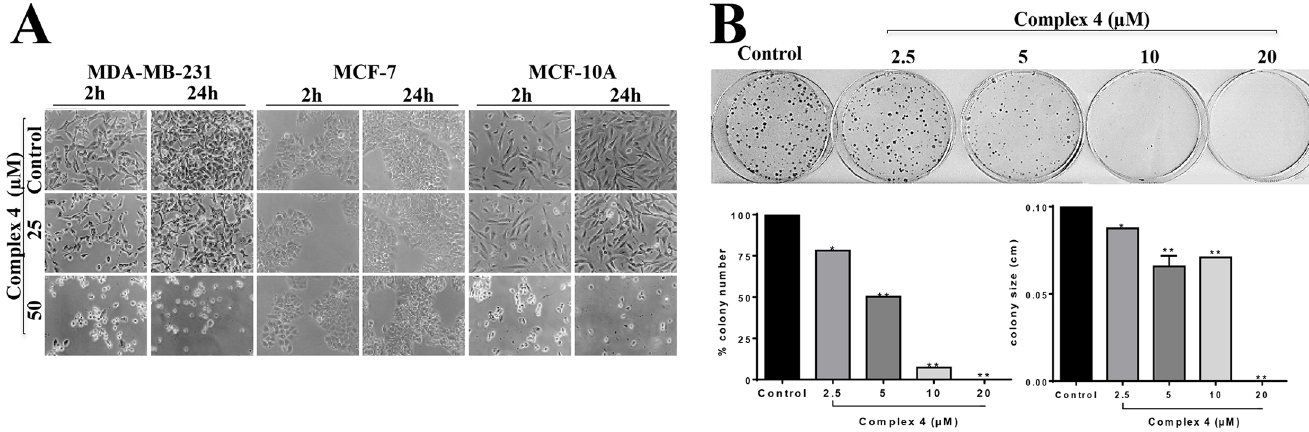
Fig 2. Effect of complex 4 on MDA-MB-231, MCF-7 and MCF-10A cells. (A) Cell morphology was examinedafter 2 h and 24 h of treatment. (B) Clonogenic assay of untreatedMDA-MB-231 cells (control) or cells treated with complex (4) . A photographof a representativeexperiment is shown along with graph quantifications of colony numberand size. Significantat the * p < 0.005, ** p < 0.001levels using ANOVA and Bonferroni tests.